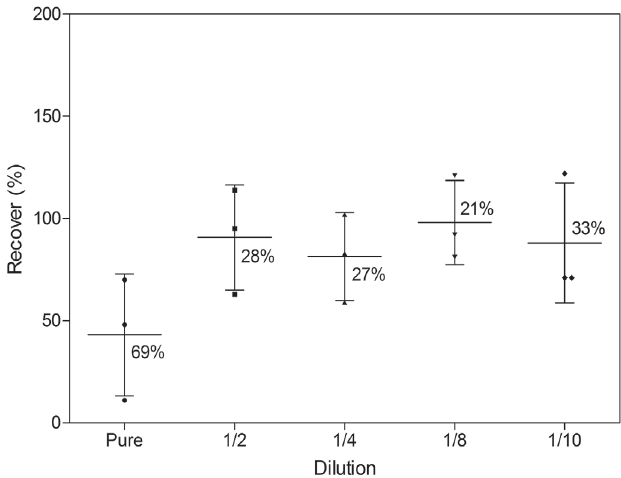
FIGURE 2 - Endotoxin recovery rate (%) of the undiluted antiserum, the diluted serum and the antiserum spiked with standard endotoxin (0.5 EU/mL). The recovery rate was calculated by interpolation from the standard curve subtracting the endotoxin equivalent of the non-spiked sample. The numbers indicate the relative standard deviation for each dilution. There were no statistically significant differences among the groups.